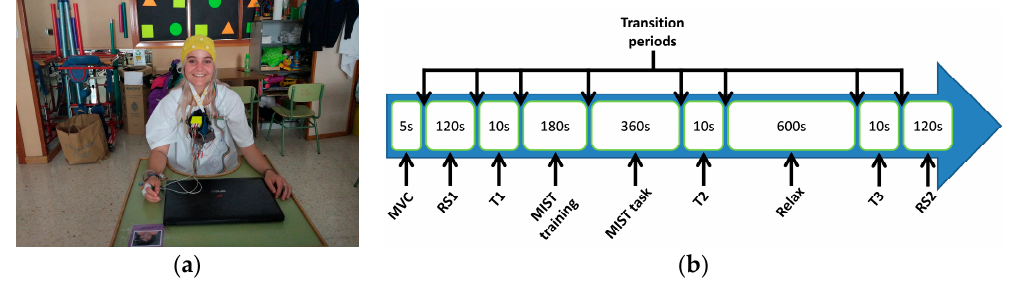
Figure 3. ( a ) Picture of one participant ready for the experiment after preparation; ( b ) timeline of the experiment. Duration of each part is in seconds (s). The total duration was around 30 min, including the transition periods (see text for details). MVC—maximum voluntary contraction; RS—resting state block; MIST—Montreal imaging stress task.